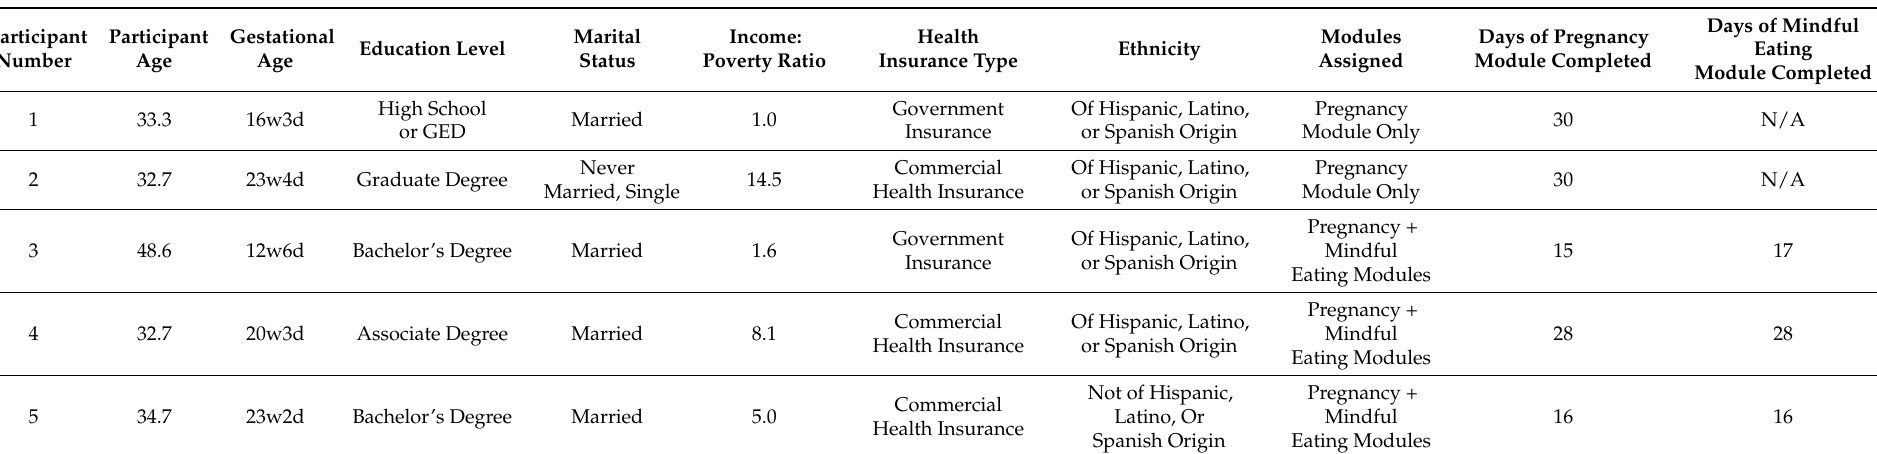
Table 1. Demographics description and engagement data for each